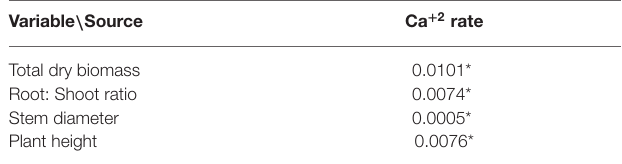
TABLE 2 | Pr > F -values from the statistical output (Anova, 5%) for Calcium (Ca + 2 ) rates in biomass